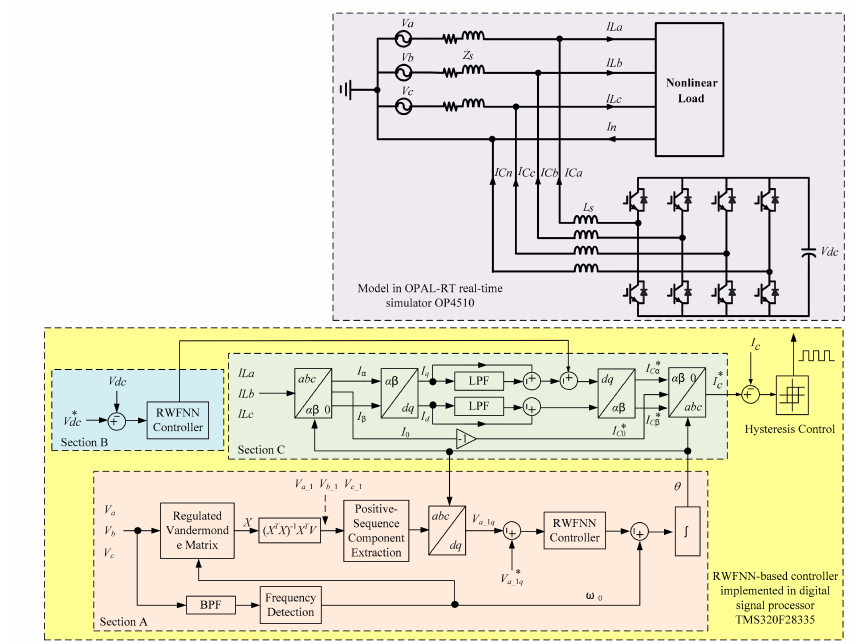
Figure 1. Proposed control strategy of reference compensation